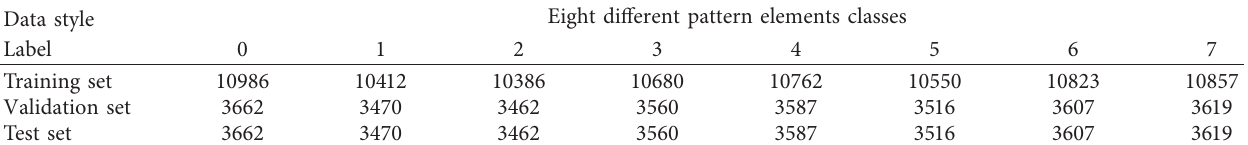
Table 1: Distribution of samples in